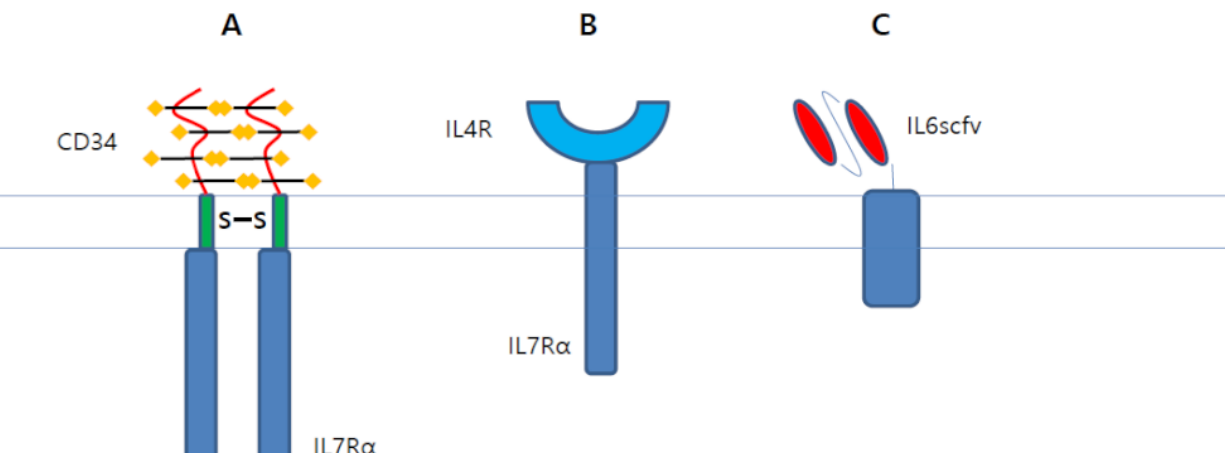
Figure 5. Artificial cytokine receptors potentiate CAR T cell activity. ( A ). C7R, which is composed of CD34 extracellular domain fused to IL7Ra transmembrane and endodomain with inserted disulfide bridge, produces active STAT5 signaling in CAR T cell. ( B ). 4/7 ICR, which is composed of IL7 receptor endodomain fused to IL4 receptor exodomain, convert immune-suppressive IL4 signaling to immune-stimulatory IL7 signaling. ( C ). mbaIL6, which is composed of IL6 scFv fused with transmembrane anchoring peptide, depleted IL6. Thus, it is anticipated that CAR T cells expressing mbaIL6 might prevent